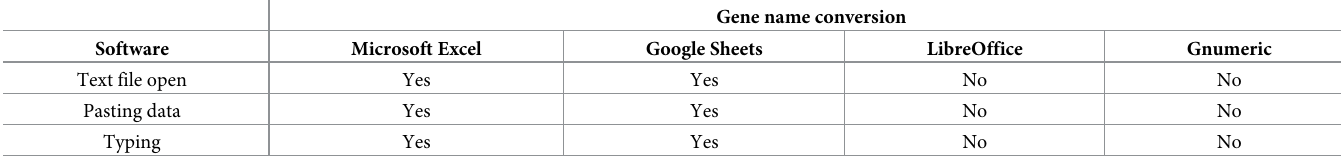
Table 1. Gene name conversion behaviour of spreadsheet